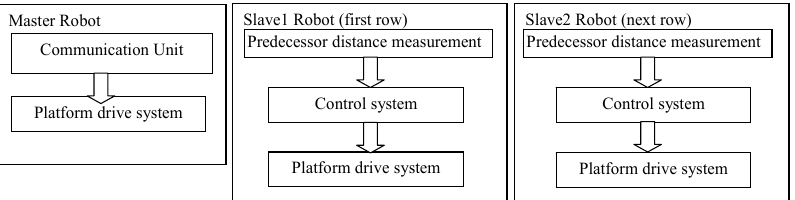
Figure 7. Basic structure of remotely controlled leader (“Master Robot”) and followers (“Slave Ro- bots”).